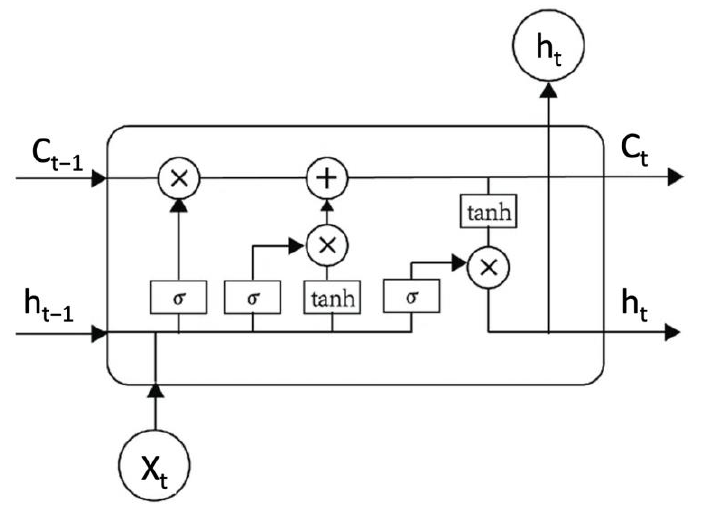
Figure 2. LSTM model representation.